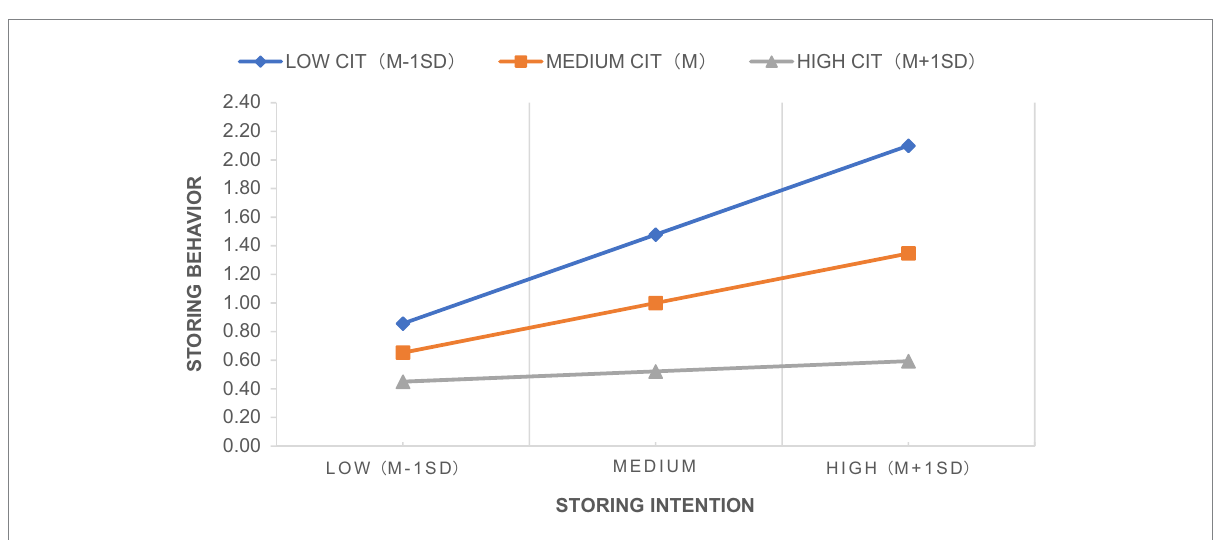
FIGURE 4 Diagram of the moderating effect of community institutional trust.